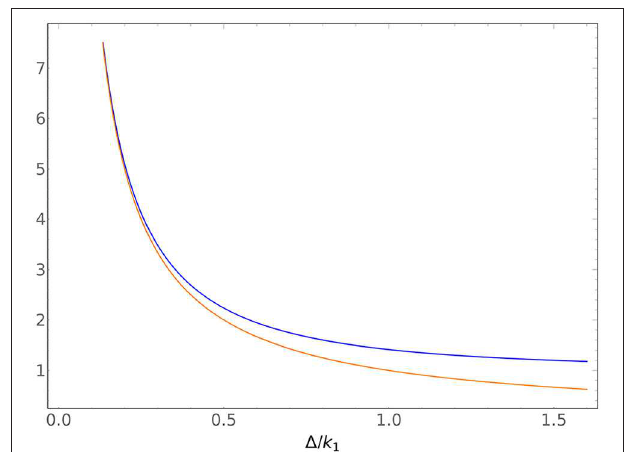
FIGURE 3 | Plot of the cross-over behavior in the k dependence of the inelastic cross-section for a Klein-Gordon particle conversion in units of 1/ k 1 , m 2 1 m 2 2 and m 1 > m 2 . The full function where 1 − = in blue, and the simple inelastic behavior 1/ k 1 is plotted in orange. Notice the q overlap for small 1/ k 1 , and the strong enhancement for large momenta.